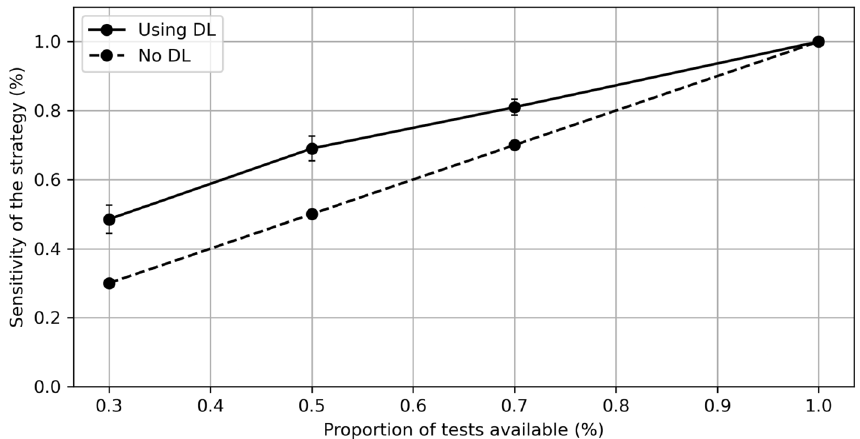
Figure 4. Inequality reductions with the use of Deep Learning (DL). Plot of the sensitivity of the fixed capacity strategy in a population according to the proportion of sequencing tests available, and with or without the